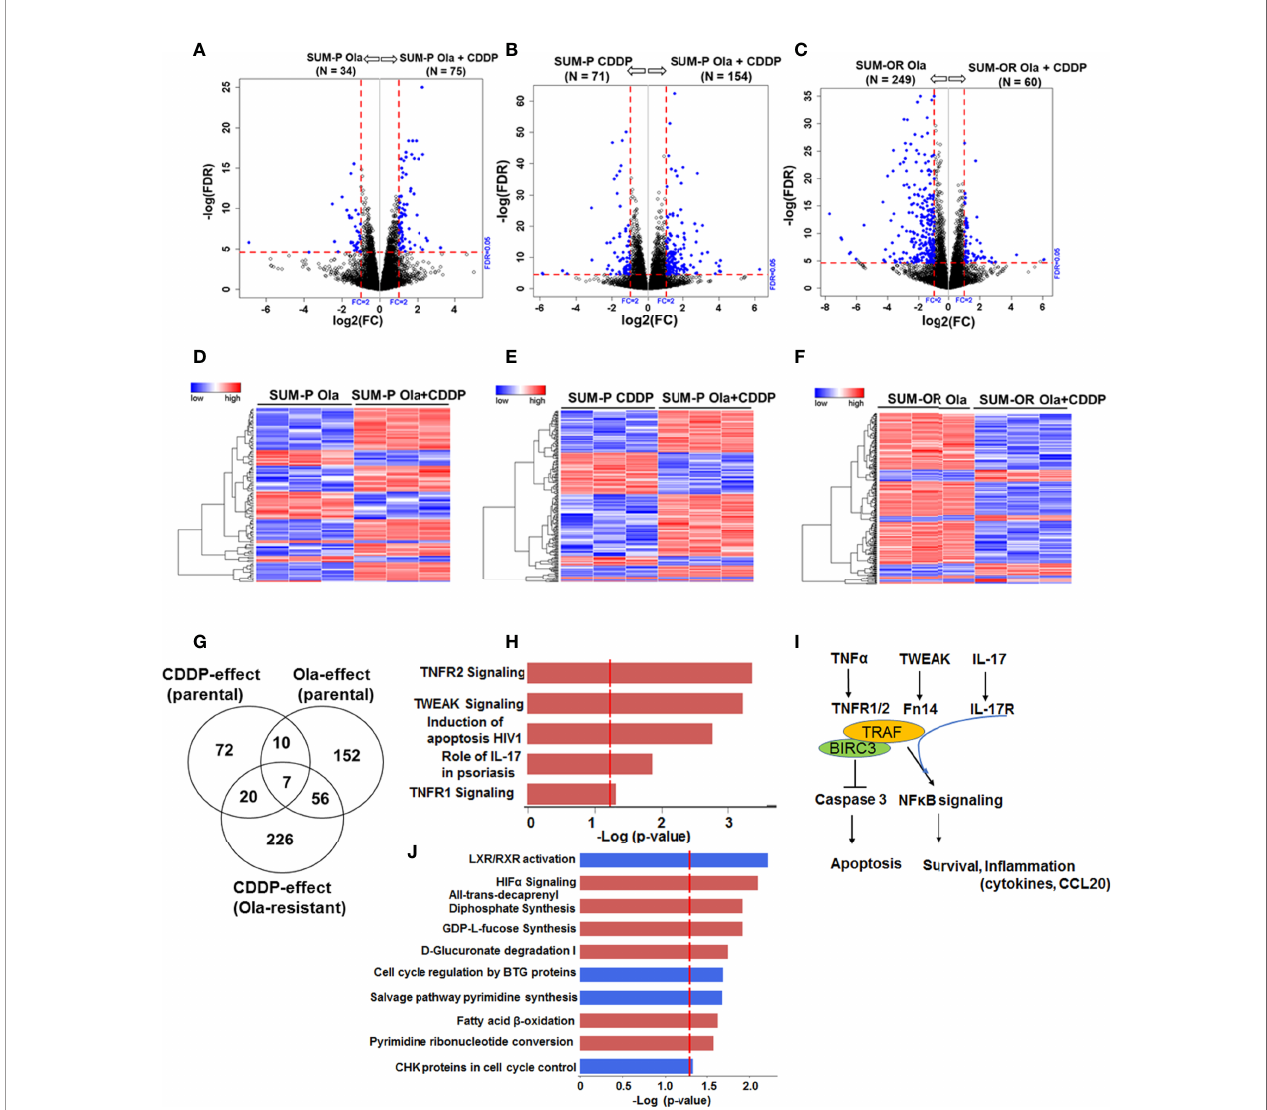
FIGURE 6 | Olaparib resistant (OlaR) and parental BRCA1 mutant SUM1315 TNBC cells respond to cisplatin (CDDP) with upregulation of in fl ammatory response pathways. RNA-seq analysis was performed on isogenic parental and OlaR SUM1315 TNBC cells. Parental cells were treated with 4 m M cisplatin (CDDP), 8 m M olaparib, or their combination. Note that the OlaR cells represent cells that were maintained in 25 m M olaparib without interruption and were used as such or treated with 4 m M CDDP. (A – C) Volcano plots. Each point in the volcano plot represents one gene. The blue and black dots represent differentially expression genes (DEGs) and unchanged genes, respectively. The horizontal and vertical dotted red lines indicate 5% FDR and fold-change (FC) of ≥ 2, respectively. The numbers (N) in parentheses at the top are the total number of DEGs that have larger expression levels in the corresponding group. (D – F) Hierarchical cluster maps; (G) Venn diagram of DEGs, 5% FDR and FC ≥ 2) and overlap in olaparib- and CDDP-induced genes in parental and OlaR counterparts. (H) CDDP impacted canonical pathways (red, upregulation) identi fi ed by IPA of 20 DEGs in the Venn diagram and (I) schematic representation of the affected pathways. (J) Canonical pathways affected by olaparib (red, upregulation and blue, downregulation) in parental cells identi fi ed by IPA corresponding to 152 DEGs in the Venn